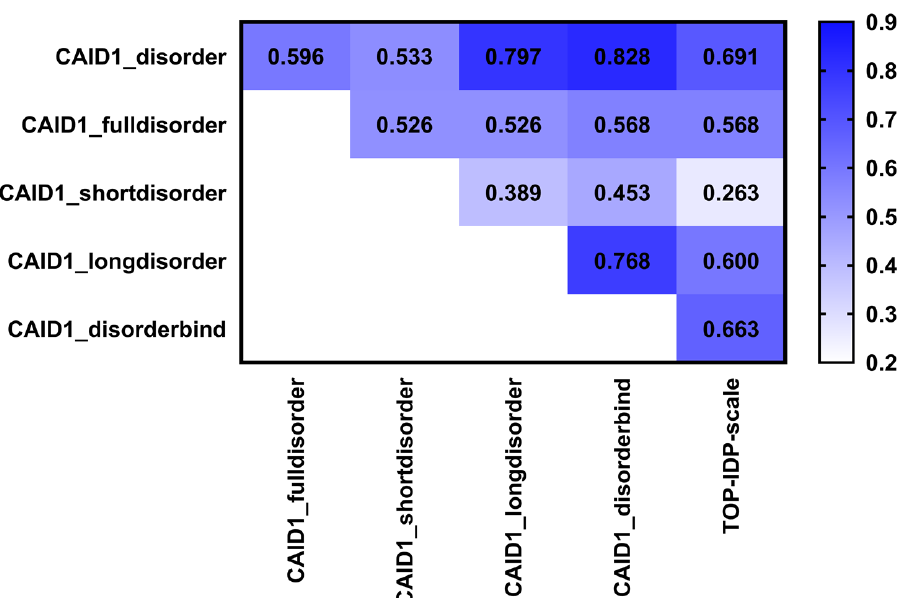
Figure 2. Kendall rank correlation coefficients (KCCs) between the AA biases for disorder in the overall CAID dataset, each of the four categories of IDRs (short, long, fully disordered and binding), and the TOP-IDP scale. The KCC values are color-coded from light blue for low values to dark blue for high values.